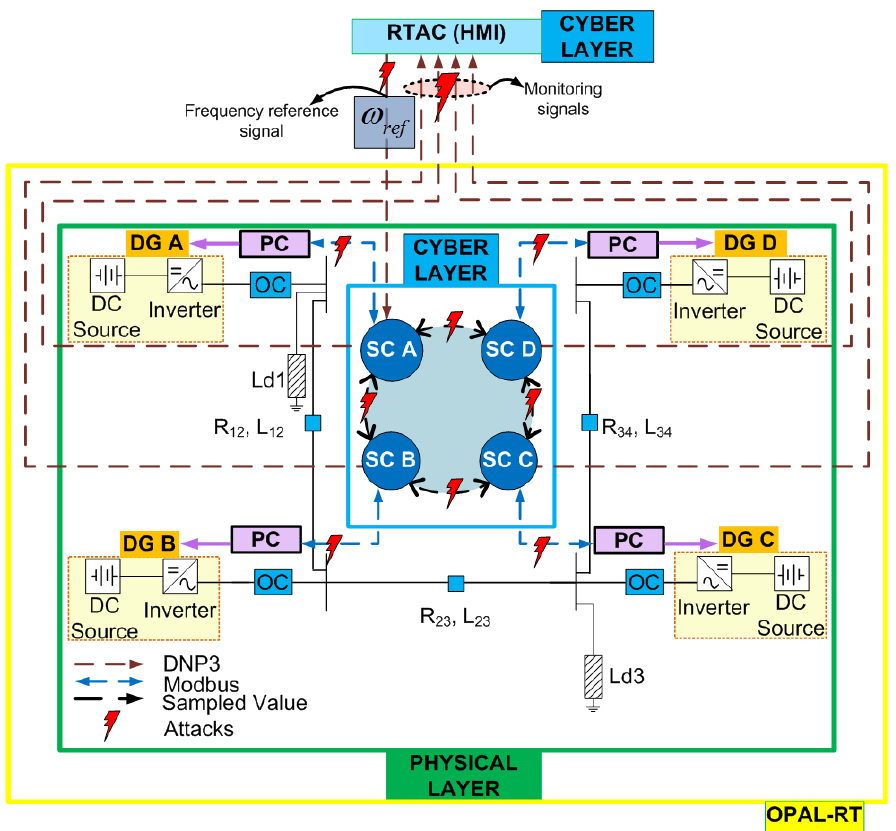
Figure 6. Control architecture of a test microgrid in the